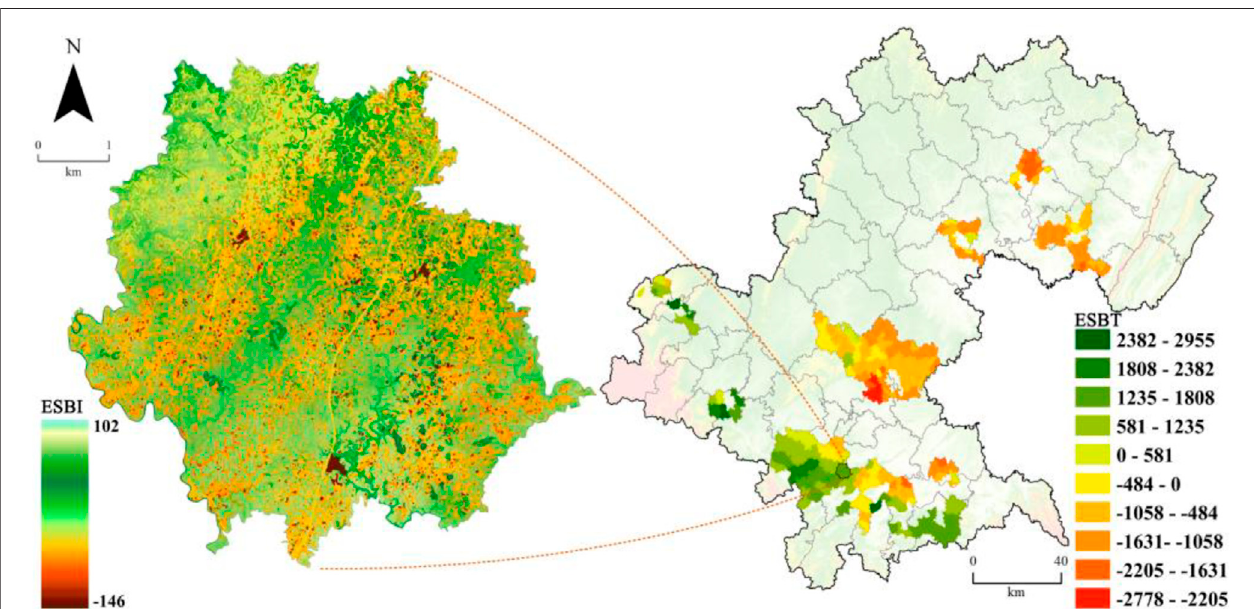
FIGURE 6 | ESBI and ESBT values of ecosystem services at different scales in typical hilly areas, SW